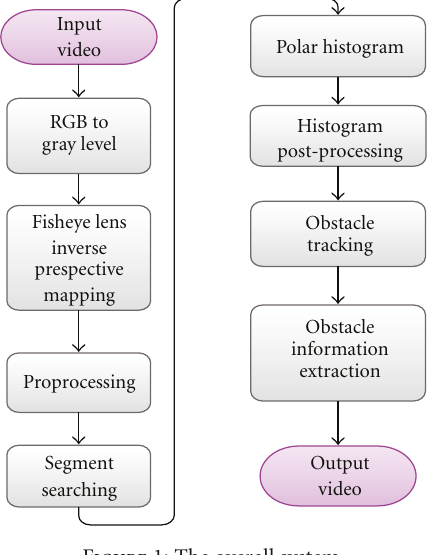
Figure 1: The overall system.